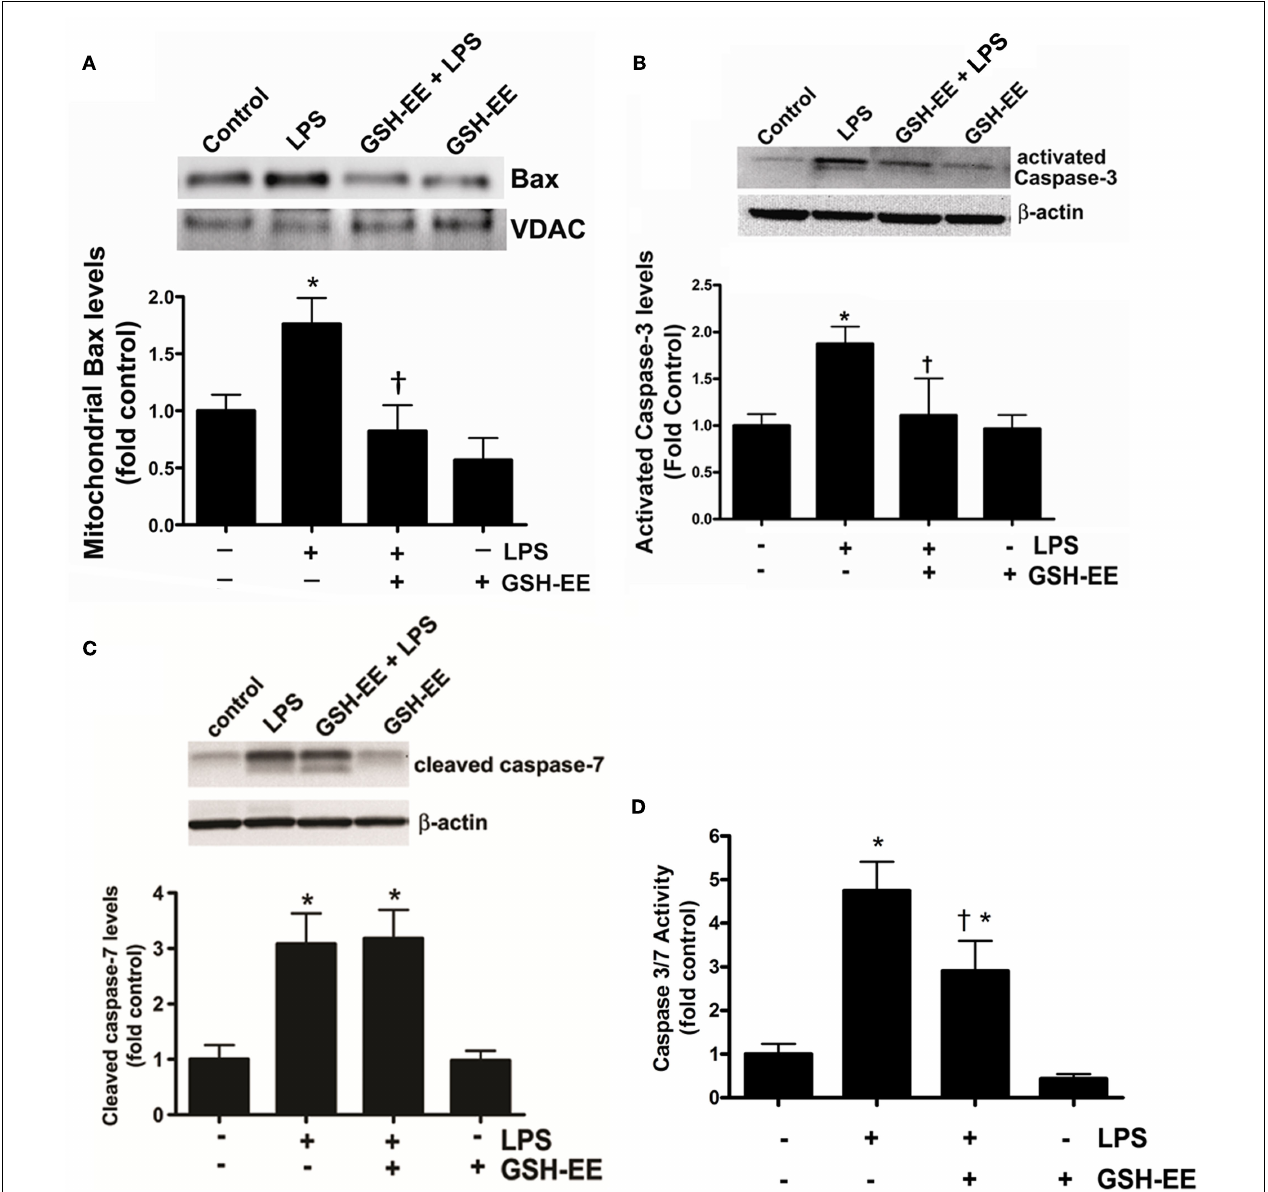
increased activated caspase 3 protein levels that was reduced by GSH-EE pre-treatment (B) .The activated caspase 7 protein levels were also upregulated in LPS-treated mice, but did not change after GSH-EE pre-treatment (C) .The increase in activated caspase 3 protein levels correlated with an increase in caspase 3/7 activity in lungs of mice exposed to LPS, which was significantly decreased in presence of GSH-EE (D) .Values are mean ± SEM; n = 3–6/group. * P < 0.05 vs. vehicle; † P < 0.05 vs.